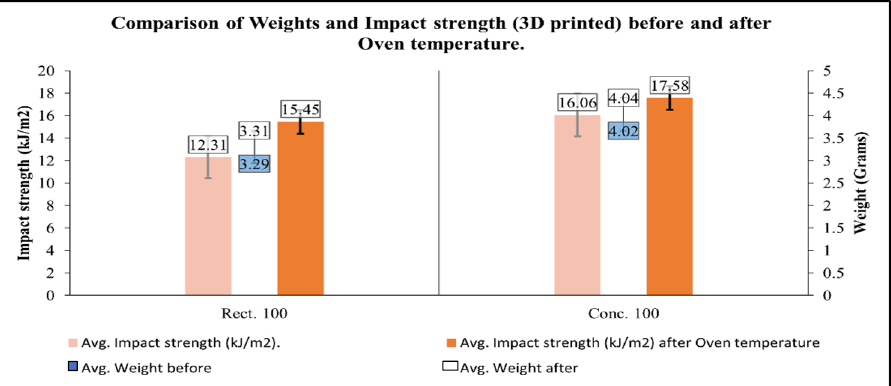
Figure 15. Comparison between weights and impact strength of PLA 3D-printed samples before and after oven temperature treatment.